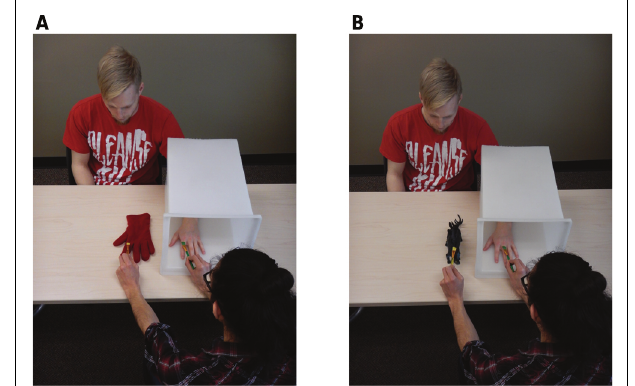
FIGURE 2 | The rubber hand illusion. (A) The participant extends their left hand into the enclosure so they cannot see their hand. They stare at the rubber hand, or glove (shown here), that is in an identical orientation to their hand in the enclosure. The person administering the illusion uses both paint brushes to touch the participant and the rubber hand in an identical manner. The illusion usually takes 1–2 min to take effect. (B) In some participants who are very susceptible to the illusion, another object may be placed where the rubber hand was. In this example, the person administering the illusion would “paint” the dinosaur and the hand in an identical manner. For some people the dinosaur will feel like it is a part of the body. touch their nose with a finger while the biceps tendon of that arm is vibrated (see Figure 1 ). The phantom sensation that is produced in some participants (Burrack and Brugger, 2005) is an